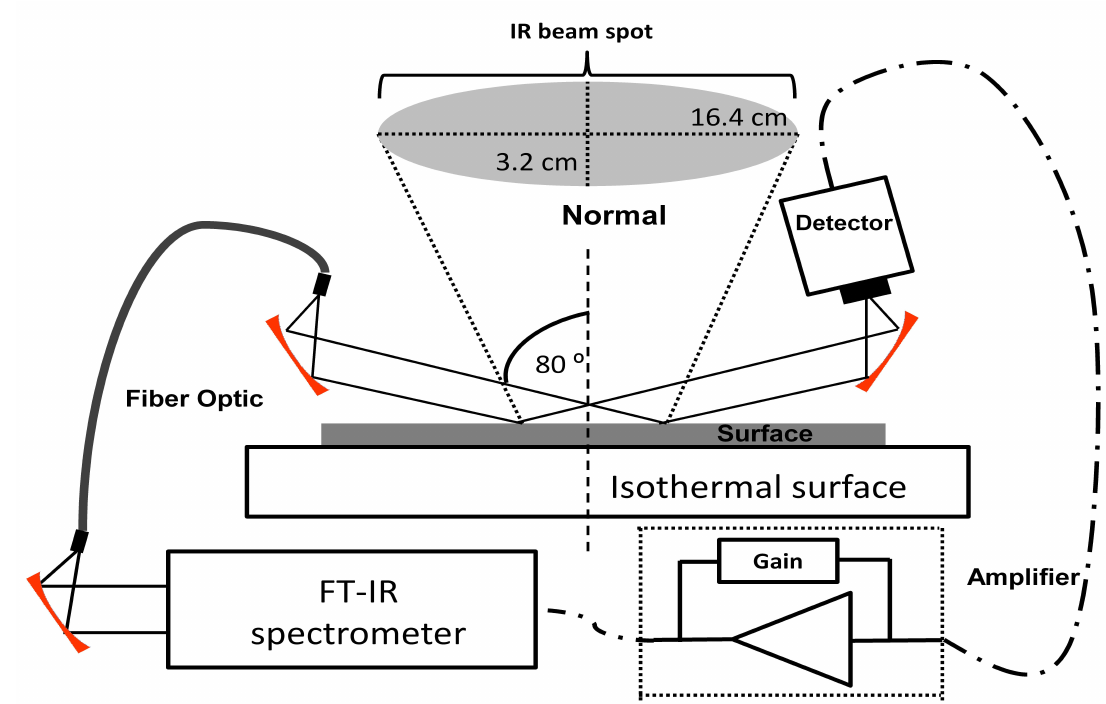
Figure 1. Grazing angle probe fiber-optic (GAP) experimental setup for the sublimation highly energetic material